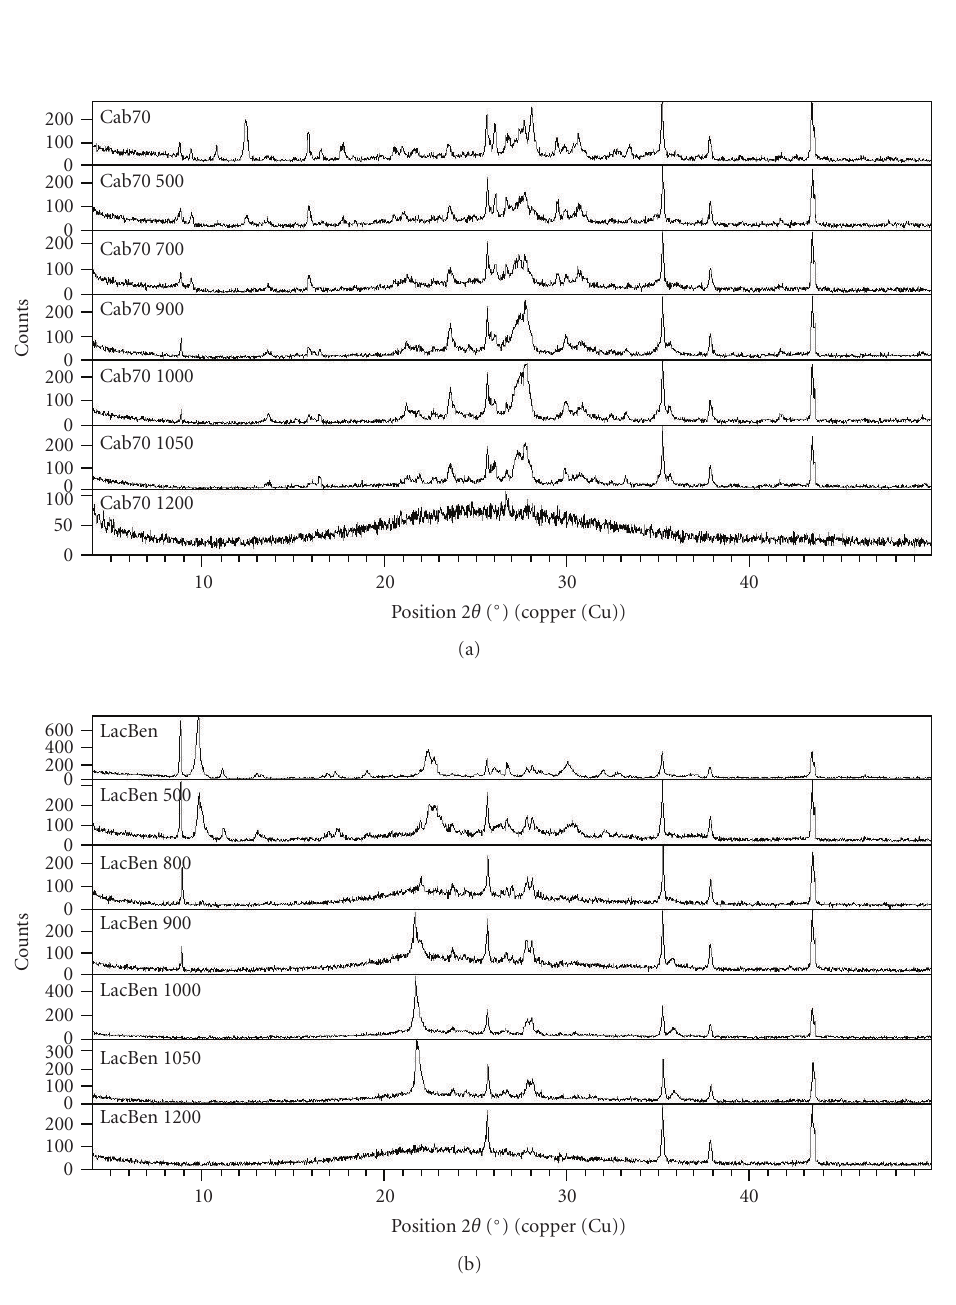
Figure 2: X-ray di ff raction patterns of untreated and thermally treated Cab70 and LacBen powders for 5 hours at 500, 700, 800, 900, 1000, 1050, and 1200 ◦